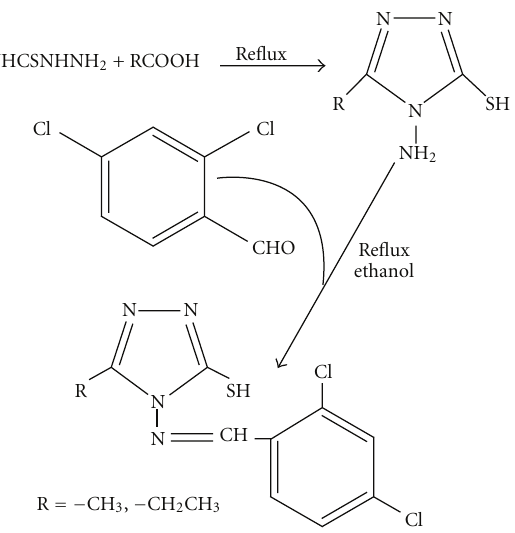
Figure 1: Scheme for the synthesis of Schi ff